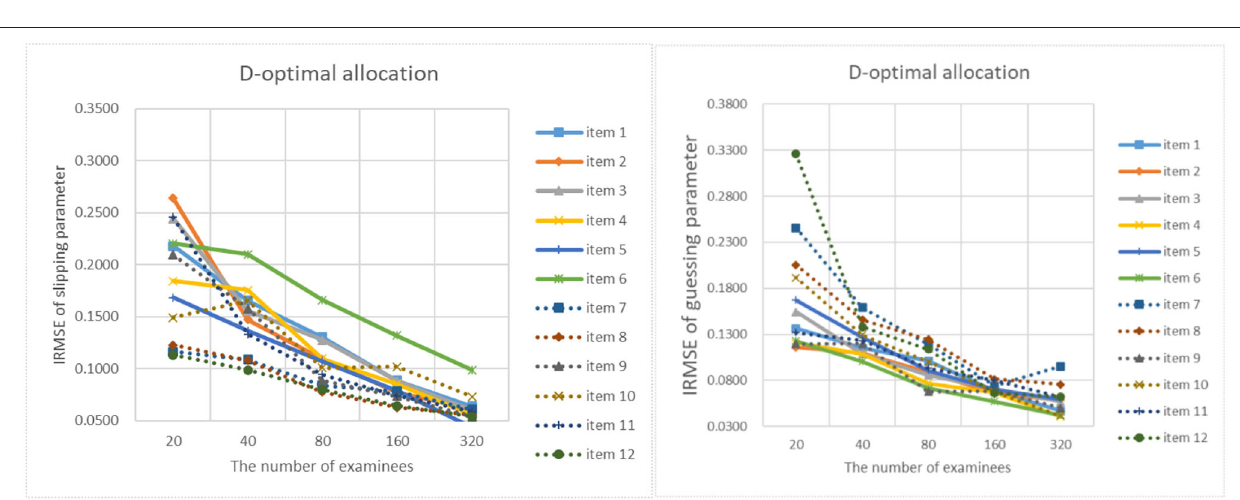
FIGURE 10 | The RMSE of each item parameter of the D-optimal allocation strategy when the initial value of the item parameter is